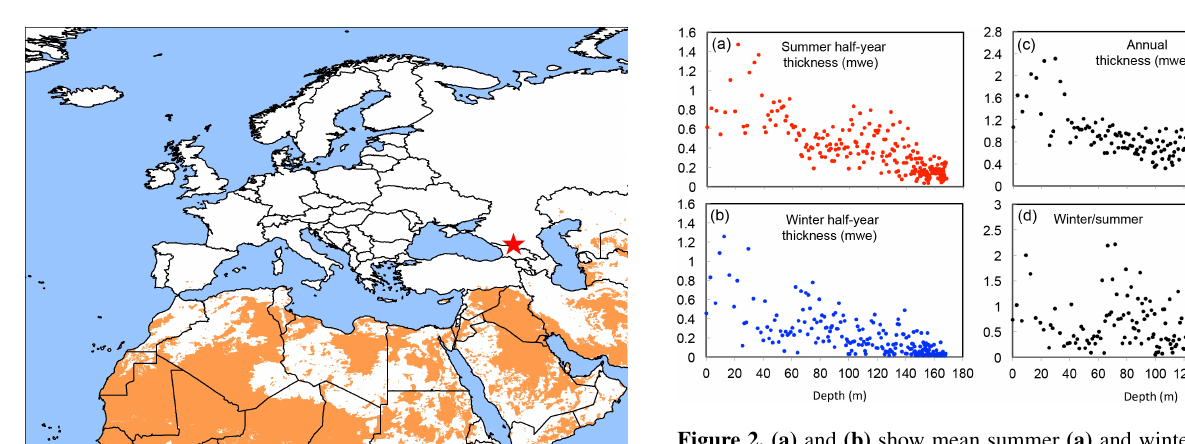
Figure 2. (a) and (b) show mean summer (a) and winter (b) half- year ice thickness along the Elbrus deep ice core. (c) shows mean annual ice thickness and (d) summer-to-winter ratio of ice thick-